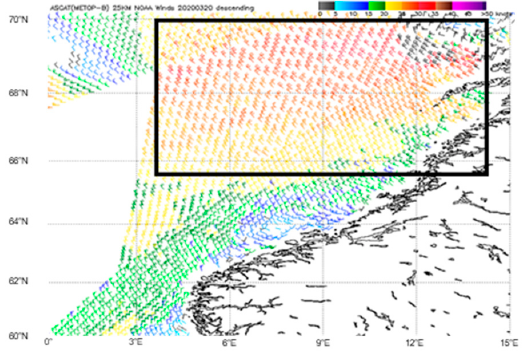
Figure 15. Wind speed (knots) data obtained using the ASCAT scatterometer at 11:00 UTC March